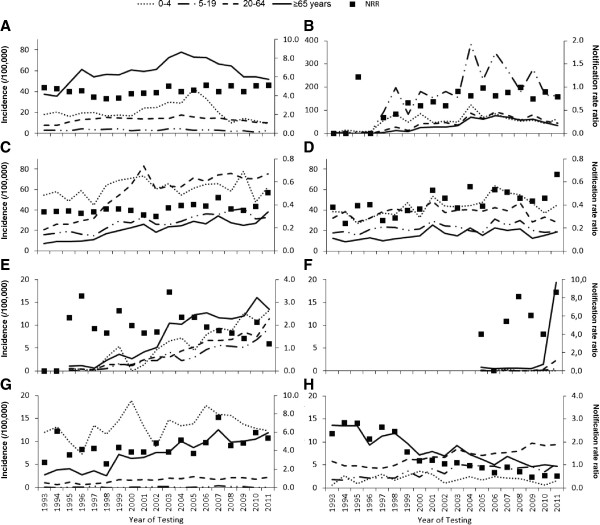
Trends in age-specific annual notification rates (lines) and notification rate ratios (dots) of notified infectious diseases. A: invasive pneumococcal disease, B: pertussis, C: campylobacteriosis, D: salmonellosis, E: MRSA infections, F: VRE*, G: invasive group B streptococcal disease (Streptococcus agalactiae), H: tuberculosis. Note the different Y-scales; both for the notification rates and for the notification rate ratios. *Note that VRE infections and carriage are only notifiable since 2005.